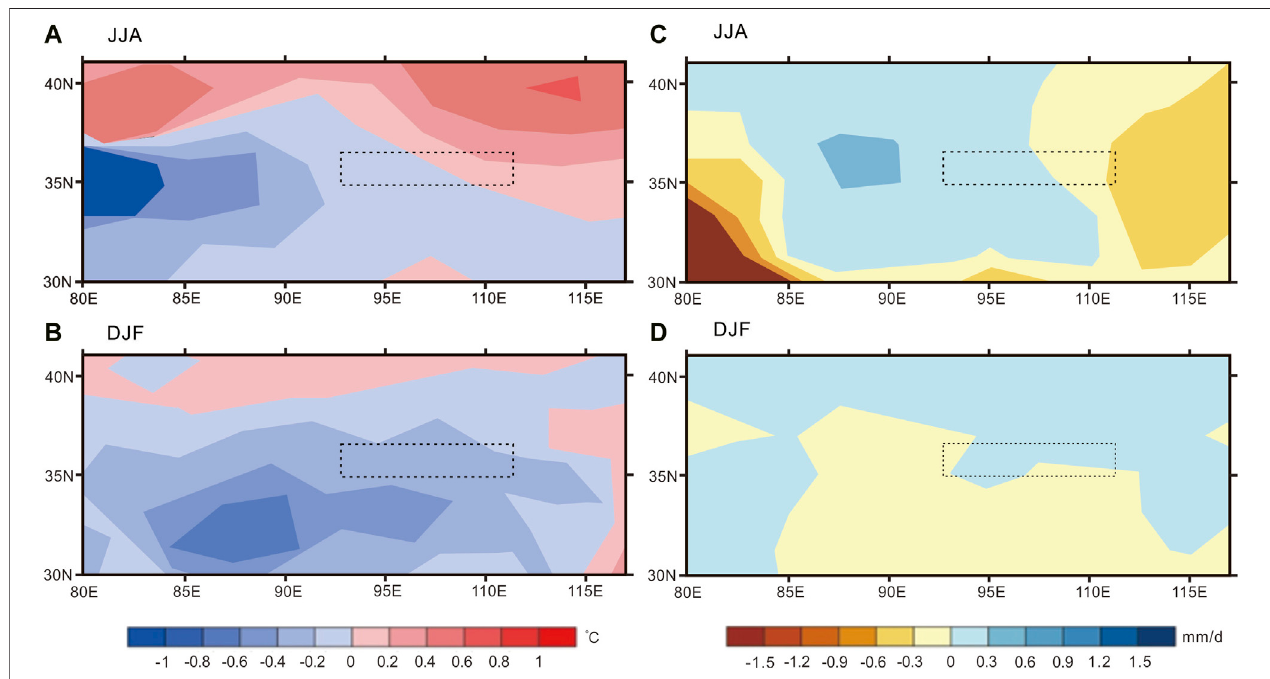
FIGURE 6 | Changes in summer (June – August) and winter (December – February) surface temperatures (A) and (B) and precipitation rates (C) and (D) due to the glacier expansions over the northern TP during the LGM (modi fi ed from Liu et al., 2020). The dashed rectangle is the covered region of this study.